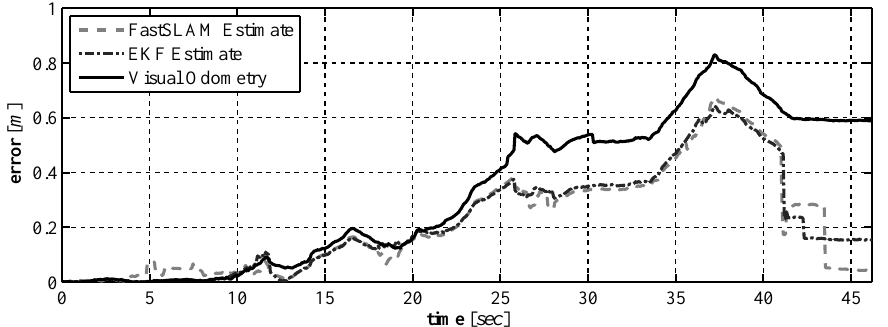
Figure 27. Comparison of the position error using the raw sensor data against the position error of the two SLAM